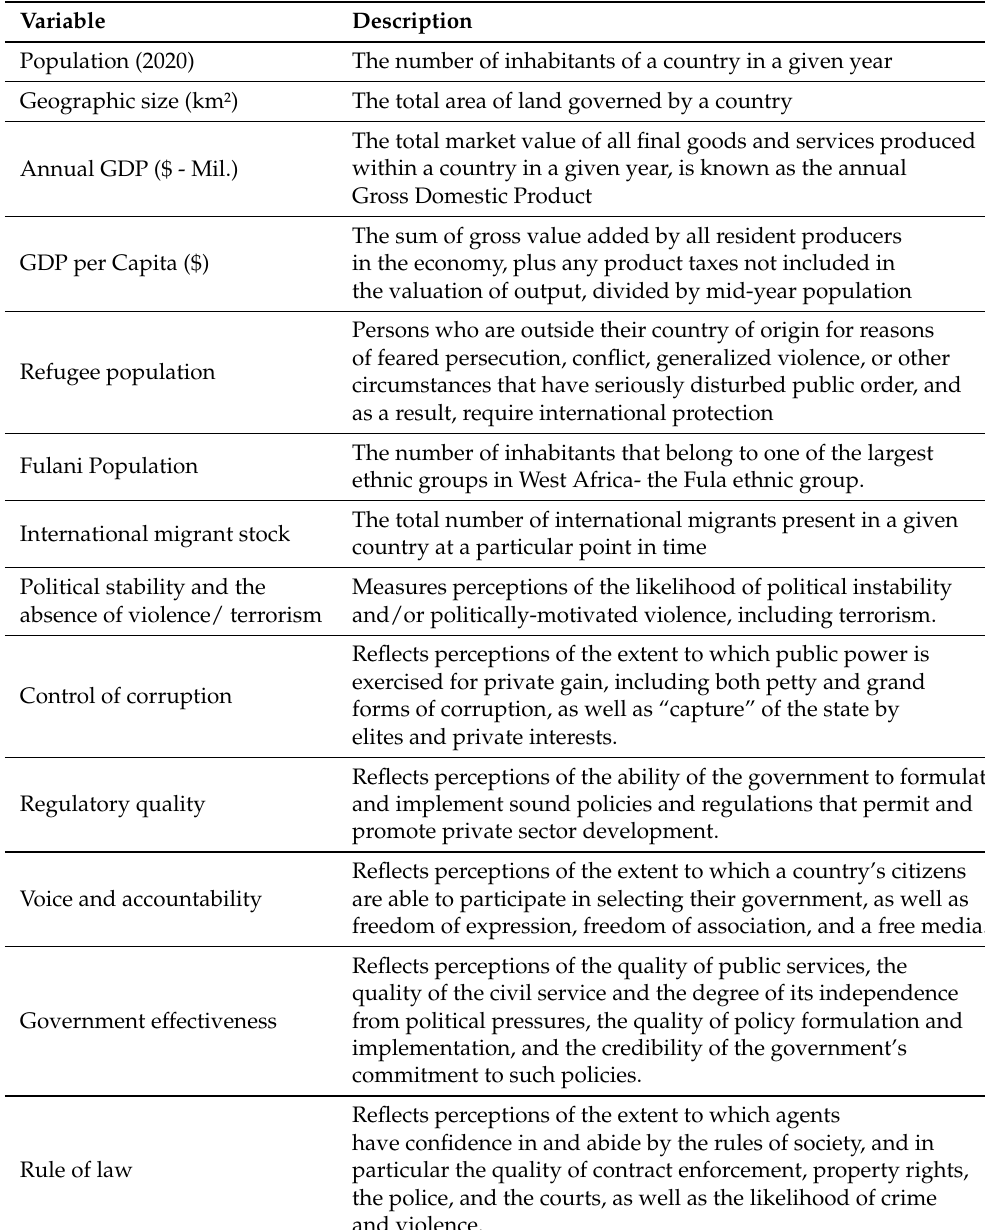
Table 5. Description of the variables considered in the multiple regression